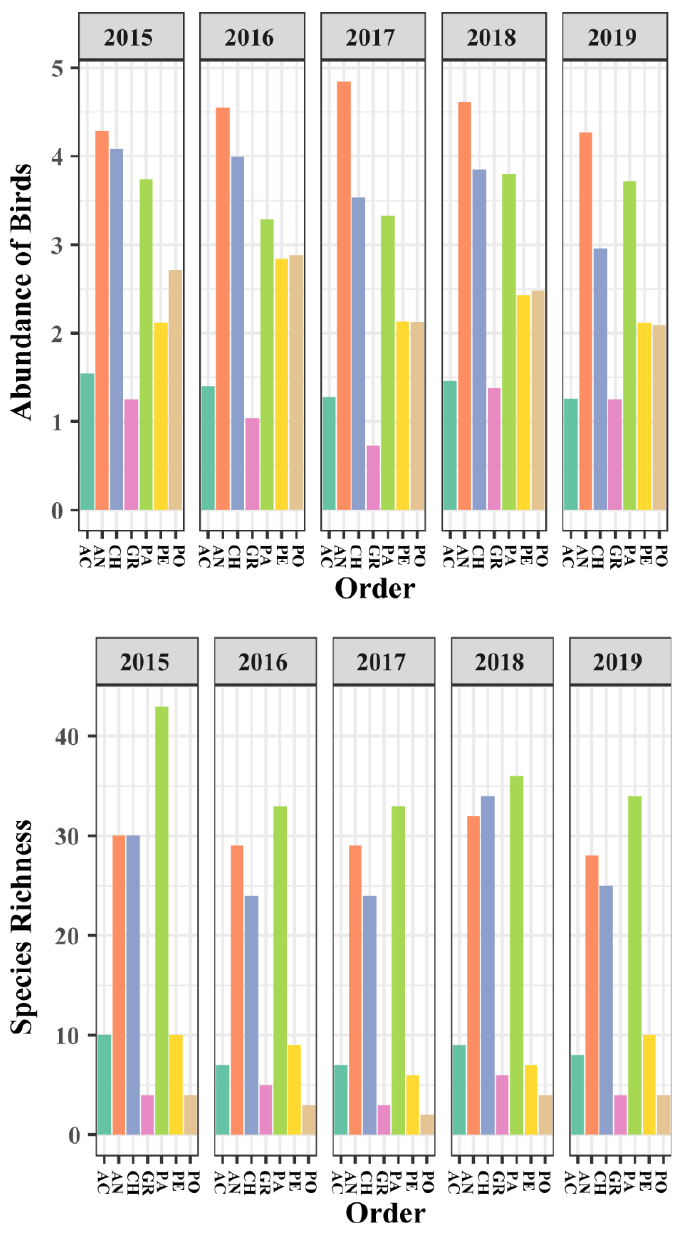
Figure 3. Annual abundance of birds and species richness sorted by orders. Data for abundance of birds were presented in logarithmic form. AC: Accipitriformes; AN: Anseriformes; CH: Charadriiformes; GR: Gruiformes; PA: Passeriformes; PE: Pelecaniformes; PO: Podicipediformes.